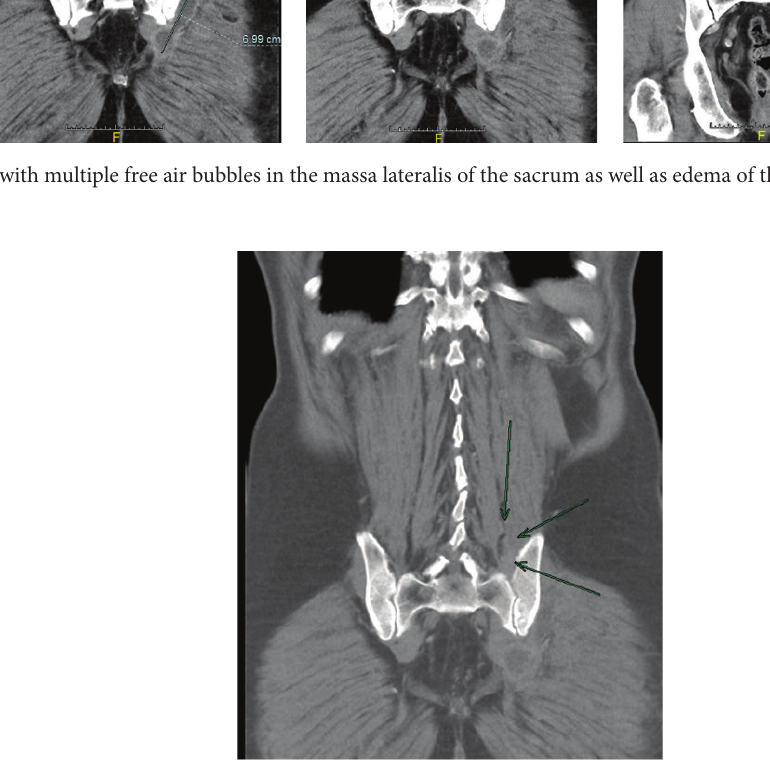
Figure 4: Abscess formation around the piriformis muscle and beginning osteolytic destruction of the ilium bone.